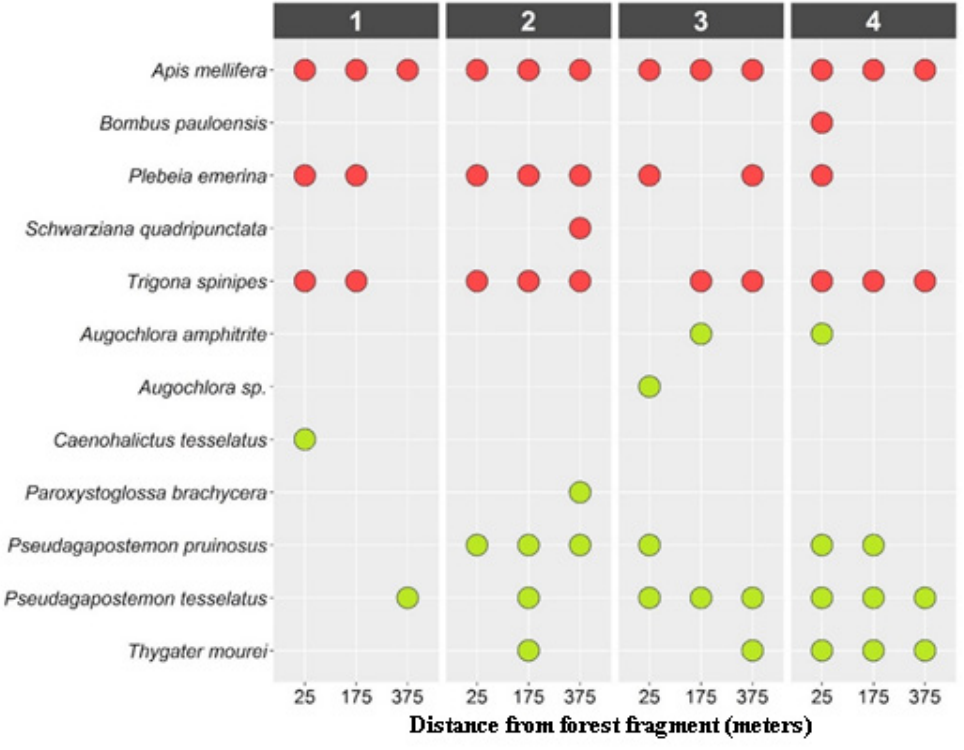
Fig 2 . Location of bees collected within four canola fields at three distances from forest remnants (25 m, 175 m, 325 m). Red circles represent social species, while green circles represent solitary species.